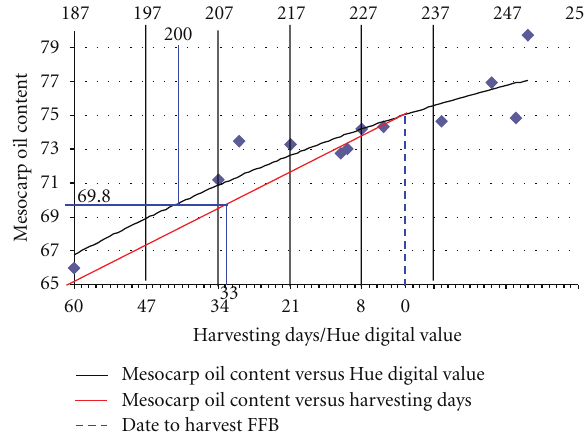
Figure 12: The model of the harvesting days for FFB 5 years old oil palm tree.